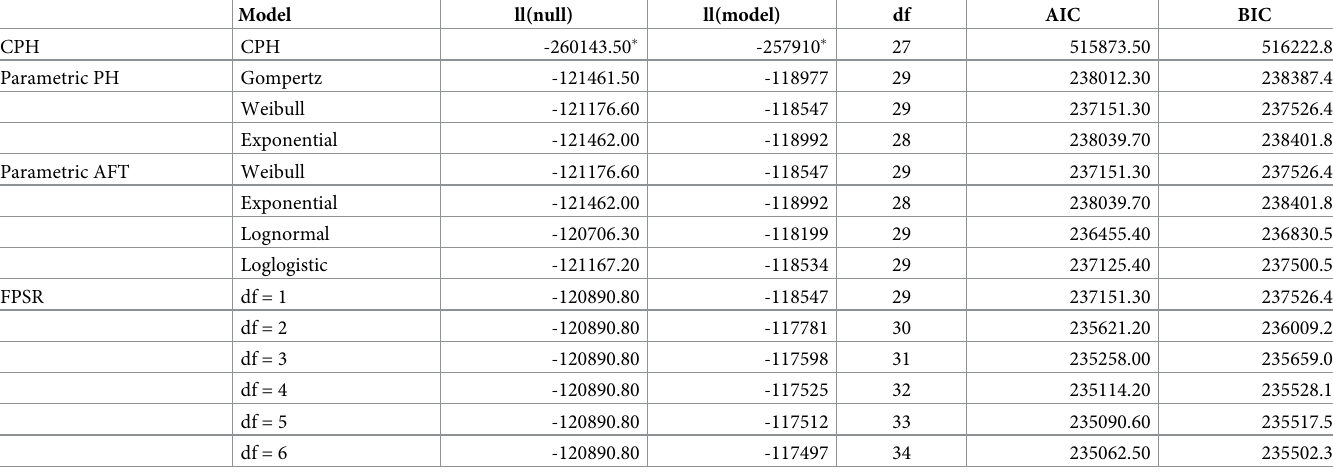
Table 2. Comparison of the loglikelihood, AIC and BIC of the models